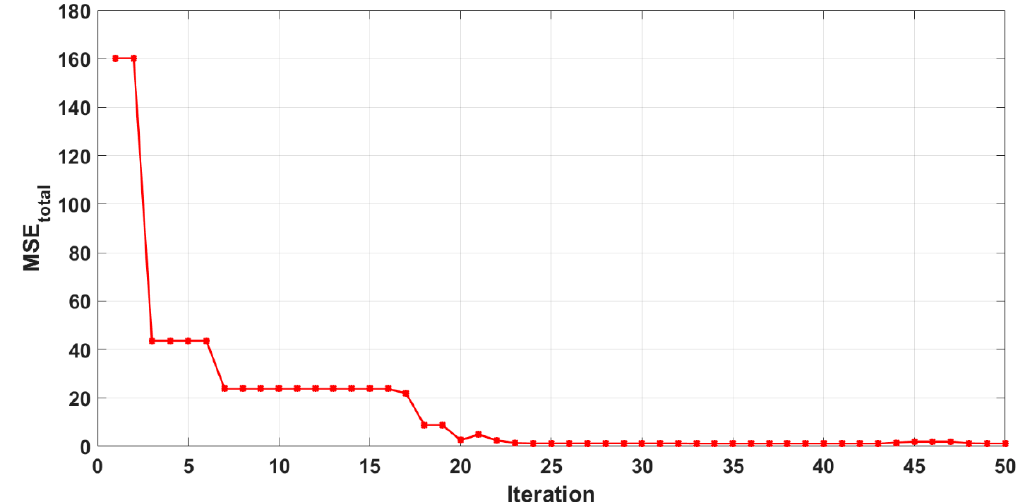
Figure 6. Number of training iteration for the ANN. Table 4. Weights and biases used in the ANN models for the determination of: liquid, gas, and tar. j